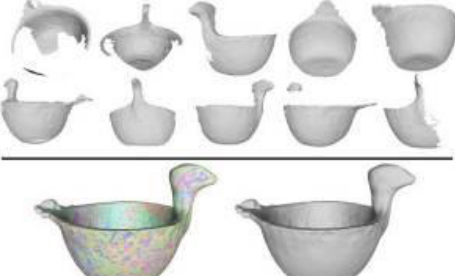
Figure 2: Partial scans and the complete 3D model that served as the reference model (ground